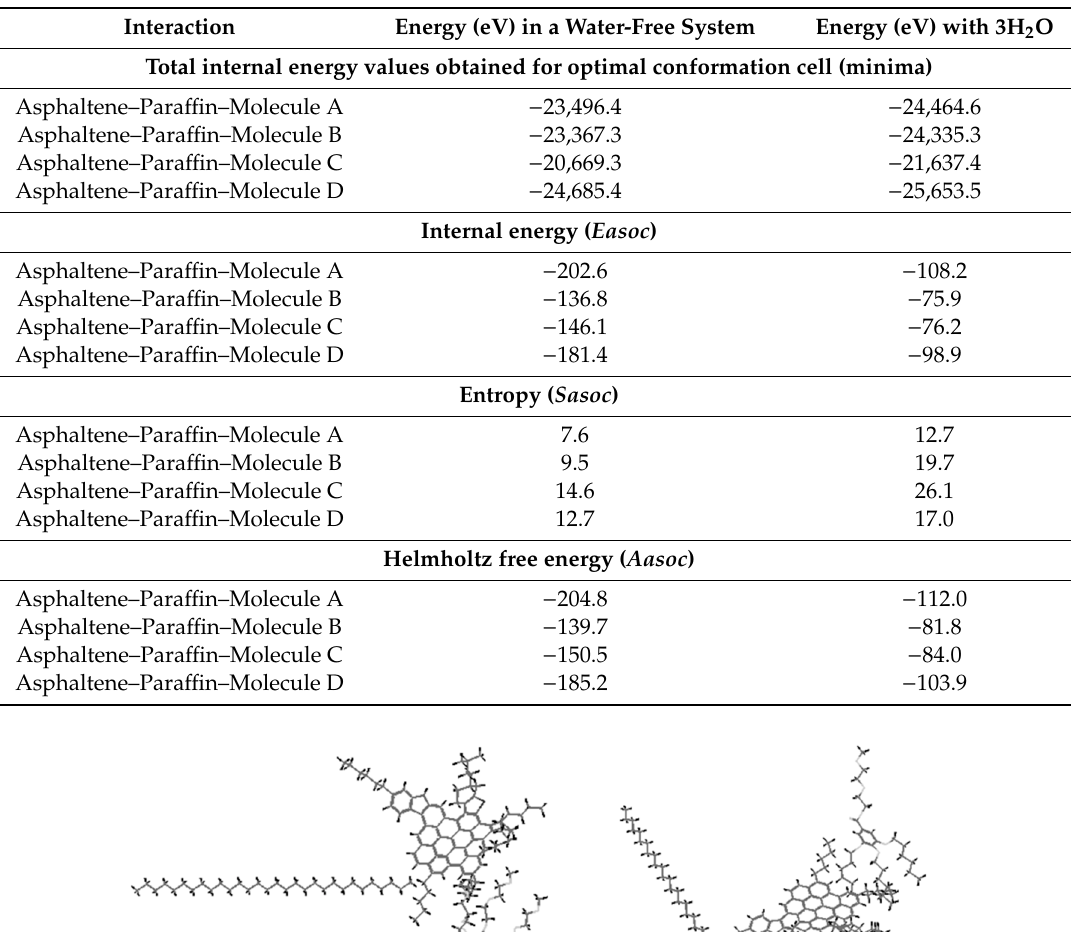
Table 1. Values of the molecular interaction energies determined using the Multiple Minimum Hypersurfaces (MMH) methodology.